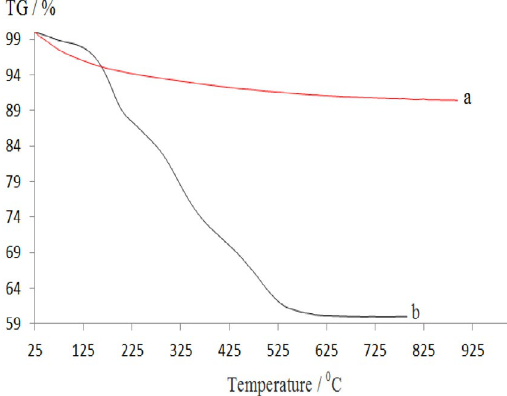
Fig. 4. XRD pattern (a) γ-alumina (γ-Al), (b) 25% ibuprofen supported γ-alumina (γ-Al-IBU25) and (c) ibuprofen